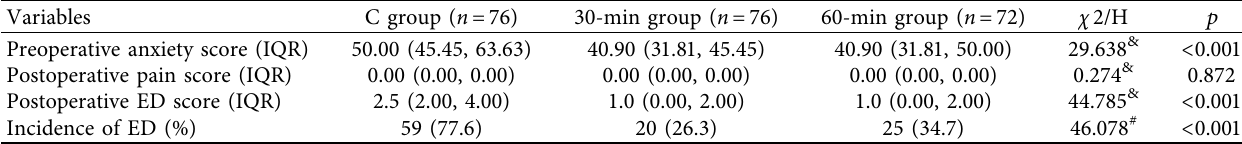
Table 2: Differences in overall study outcomes between three groups.